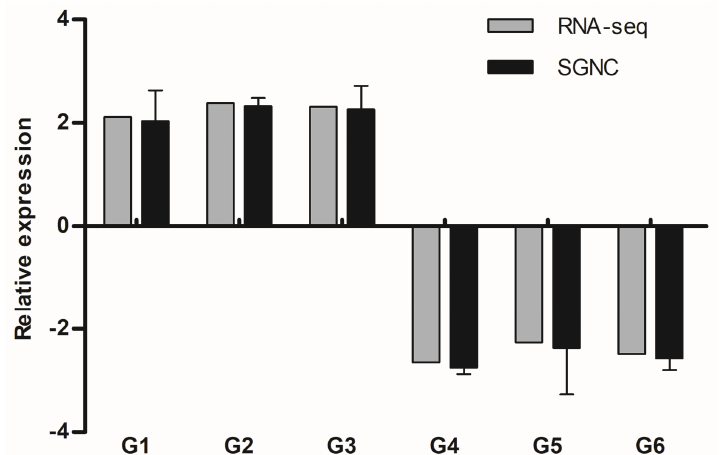
Figure 6. SGNC validation of differentially expressed genes. G1: molluscan insulin-related peptide 3; G2: clathrin light chain A; G3: monocarboxylate transporter 12; G4: tubulin beta-4 chain; G5: galectin-4; G6: cathepsin L. SGNC represents gene expression normalization to ATPA1 and PMPCB . Relative expression values represent the fold change of gene expression in the treatment group compared with the